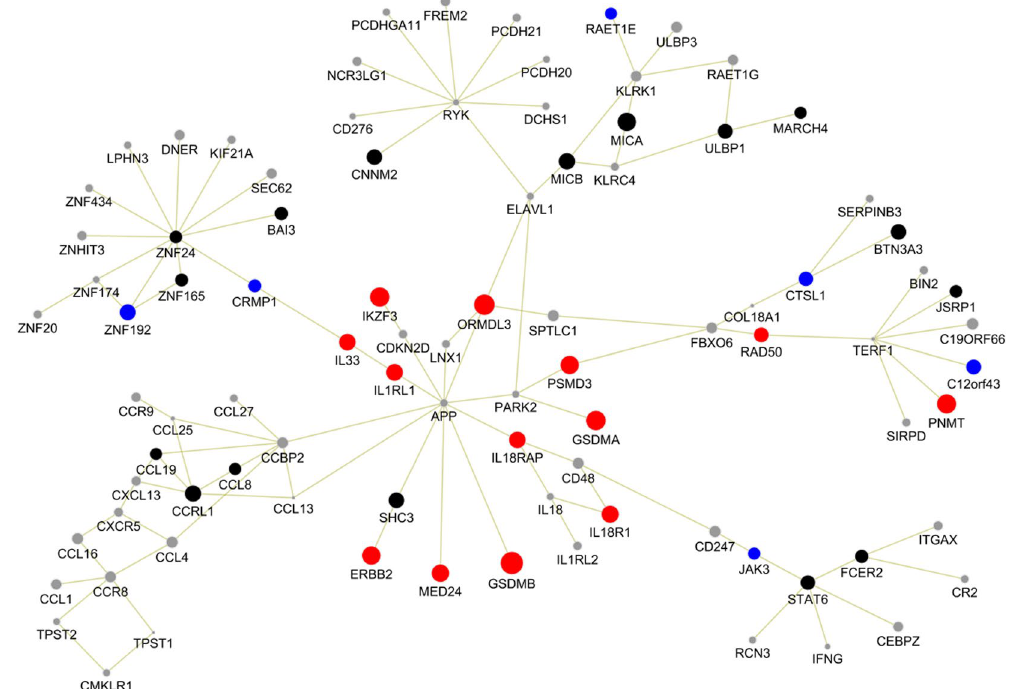
Figure 2. The gene module identified for childhood-onset asthma. The red coloured nodes represent genes at known asthma associated loci and nominally significant in both META1 and META2 datasets; the blue coloured nodes represent new module genes that are nominally significant in both META1 and META2 datasets; the black coloured nodes represent new module genes that are nominally significant in either dataset; the grey coloured nodes are not significant. The node size indicated the strength of the association (the maximum z-score of its corresponding gene in the two